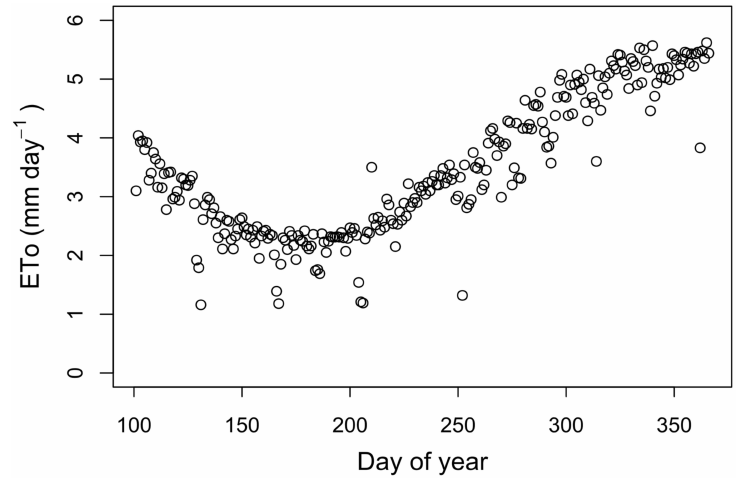
Figure 1. Reference evapotranspiration (ETo) trend of the experimental site during the trial, computed with automatic weather station data and the Penman–Monteith model.